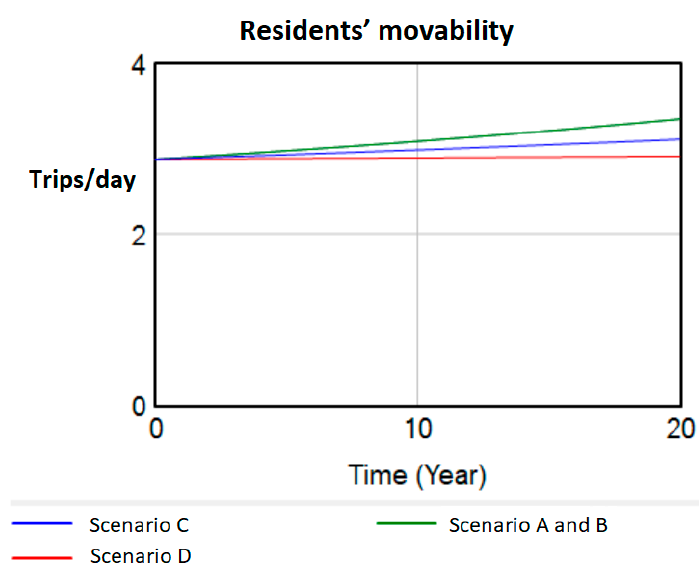
Figure 7. Residents’ movability trend over the 20 years.